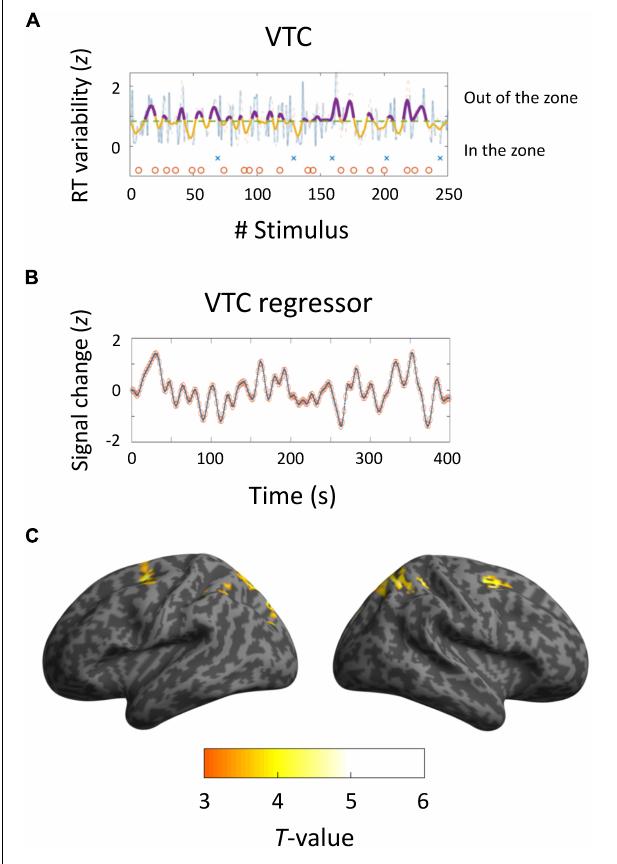
FIGURE 3 | Brain activations derived from variance time courses (VTCs). (A,B) Behavioral and neuroimaging results of a representative participant. VTCs were computed using RTs for 250 trials. Dashed lines show median VTCs. The area below the line represents in-the-zone period, whereas the area above the line indicates out-of-the-zone period. Crosses and circles indicate false alarm and correct rejection trials, respectively. VTC regressors were convolved with a canonical hemodynamic response function and downsampled to 0.5 Hz. (C) Activated areas related to VTCs ( p < 0.05, corrected at the cluster level; k =